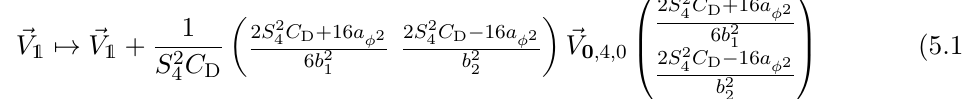
Figure 3. Six allowed regions for the OPE-space vector of the unit-normalized displacement. The dotted line shows the physical locus for ˆ λ 11 D and ˆ λ 22 D , i.e. (2.36) divided by becomes vertical (defining a unique ˆ λ 11 D in order for ˆ λ 22 D to be finite), it saturates our bound. This does not quite happen in the opposite limit of the line becoming horizontal. Note that in the GFF example there are two candidates for the displacement. Both [ b O 1 b O 1 ] 1 , 0 and [ b O 2 b O 2 ] 0 , 0 are compatible with these bounds if we treat them as different operators that satisfy ˆ λ 11 D ˆ λ 22 D = 0